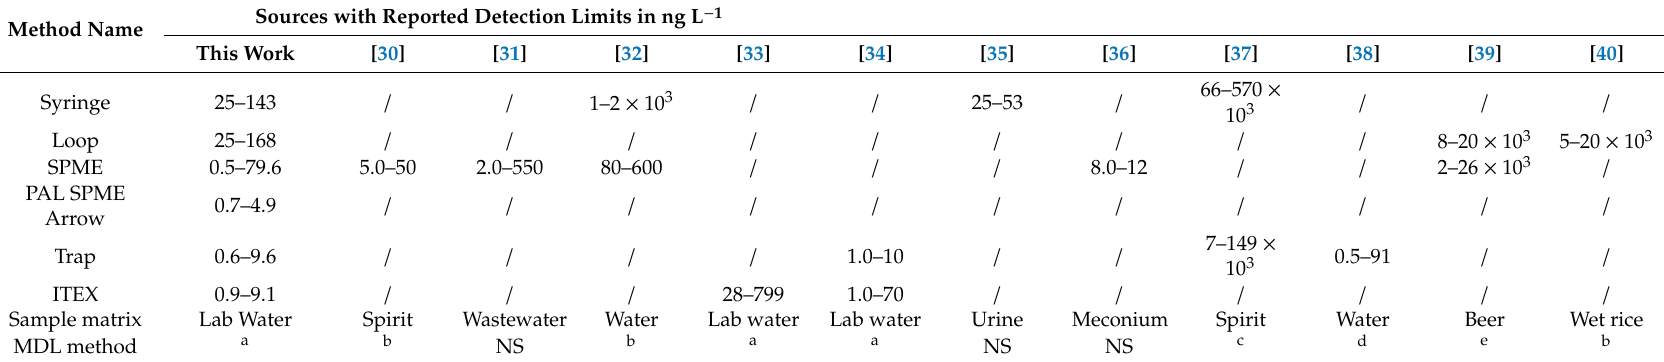
Table 3. Comparison of di ff erent headspace technologies towards the analysis of VOCs. Table reprinted with permission of Springer from Reference [29], 2019.